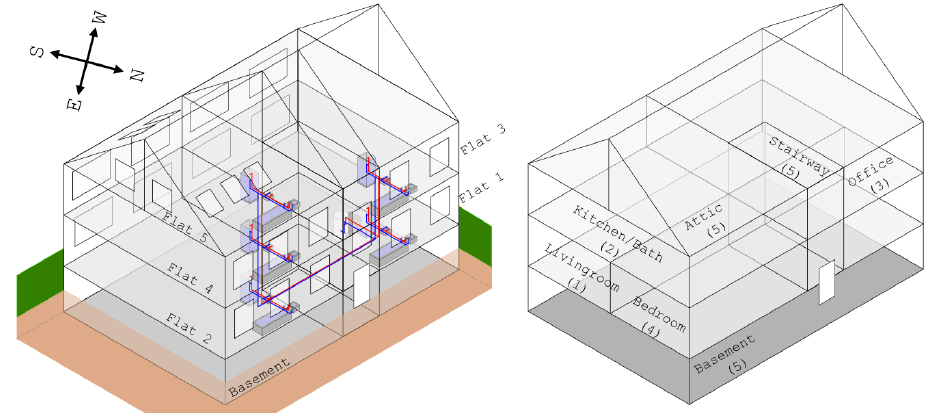
Figure 8. Schematic building structure ( left ) and simulation model representation ( right